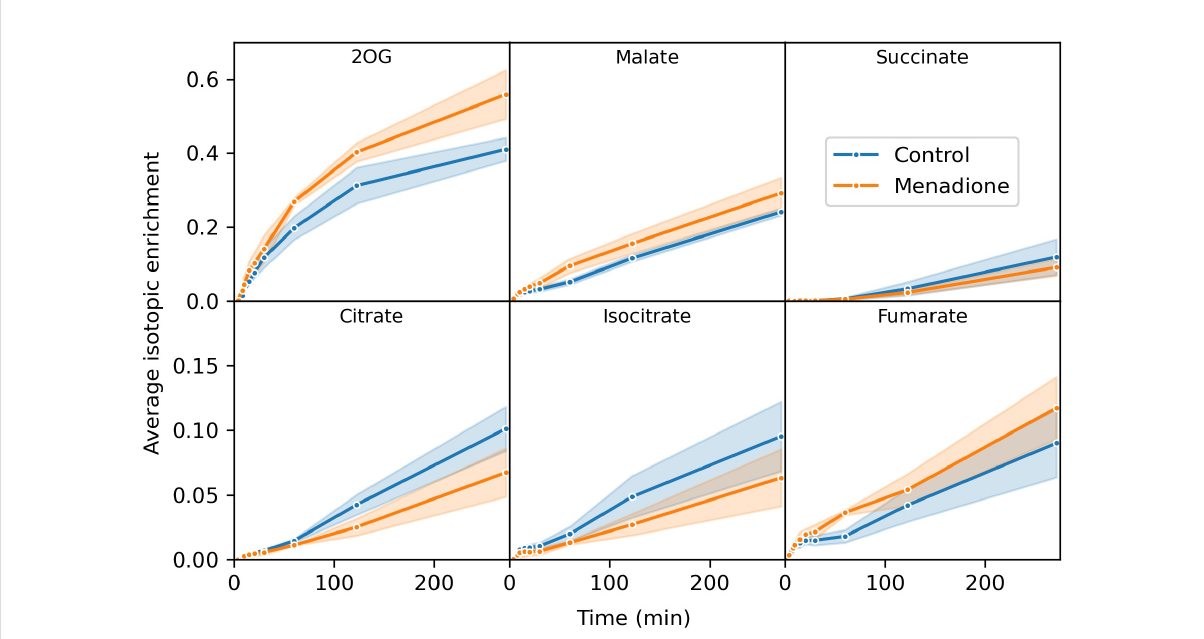
FIGURE 3 Average isotopic enrichment of TCA cycle intermediates after supply of [ 13 C 6 ]glucose to heterotrophic arabidopsis cell cultures following 6 h treatment with 60 µM menadione or untreated control. Isotopic enrichment is corrected for natural abundance of heavy isotopes and the proportion of labelled substrate in the media. Note the difference in scales on the y-axis in different panels. Values are the mean ± SD (shaded region), n =